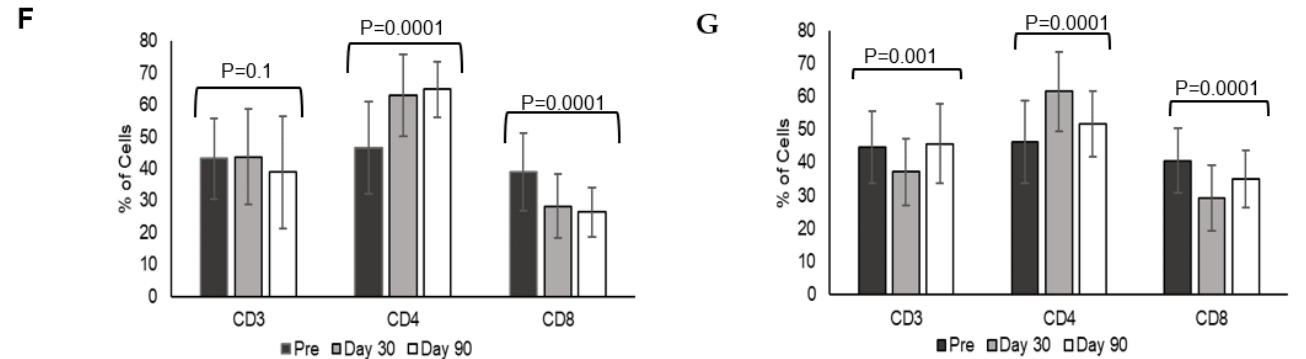
Figure 1. Booster dose vaccine elicited antibody response and immune cell response: Antibody and immune cells response in individuals receiving heterologous and homologous booster vaccine. ( A ) Comparative evaluation of SARS-CoV-2 S1/S2 spike IgG antibodies before (pre) and after booster vaccination at day 30 and day 90 with Corbevax (Heterologous) and Covishield (Homologous). ( B ) SARS-CoV-2 RBD-specific antibodies comparative evaluation before (pre) and after booster vaccination day 30 and day 90 with Corbevax (Heterologous) and Covishield (Homologous). Comparison of ( C ) CD3, ( D ) CD4, and ( E ) CD8 in between the hetero and homologous groups at pre, day 30, and day 90 and p values were compared in between the groups ( A – E ). Immune cell responses in individuals receiving booster doses—( F ) CD3, CD4, CD8 T Lymphocytes in individuals receiving heterologous booster dose with Corbevax ( G ) CD3, CD4, CD8 T Lymphocytes in individuals receiving homologous booster dose with Covishield and p values were shown together for pre, Day 30 and day 90 ( F , G ).